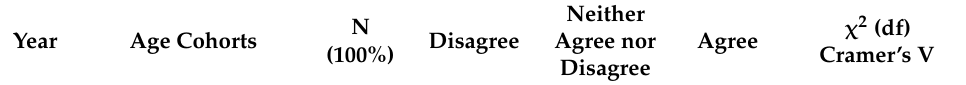
Table 4. Anti-clergy sentiments among different Roman Catholics’ age cohorts in Lithuania. Year Age Cohorts